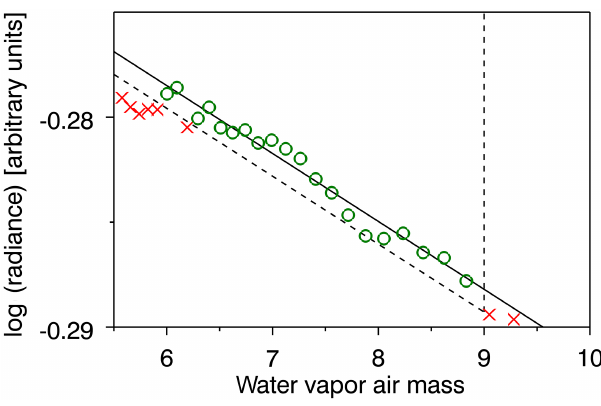
Figure 2. Selection of spectra for the Langley measurements made on 13 December 2013. The Langley plot is based on radiance mea- surements in the 4300 to 4350cm − 1 range. Continuous black line: first-estimate linear fit; dashed black line: selection threshold; green circles: selected spectra; red crosses: excluded